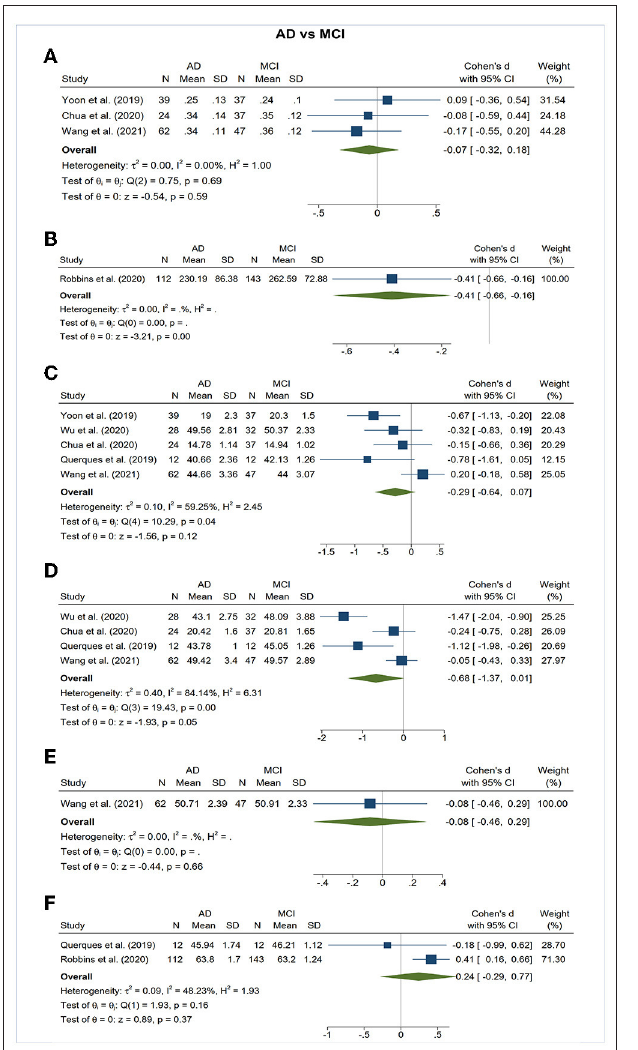
FIGURE 5 | Forest plot of OCTA measurements between subjects with Alzheimer’s Disease (AD) and mild cognitive impairment (MCI). The meta-analyses were conducted with a random-effects model. Horizontal bar indicates 95% confidence intervals (CI), and the size of the squares denotes the weight attributed to each article. The diamonds represent the standardized mean differences with the width showing the 95% CI. (A) Foveal avascular zone area. (B) Choroidal thickness. (C) Superficial capillary plexus vessel density. (D) Deep capillary plexus vessel density. (E) Peripapillary vessel density. (F) Choroidal perfusion